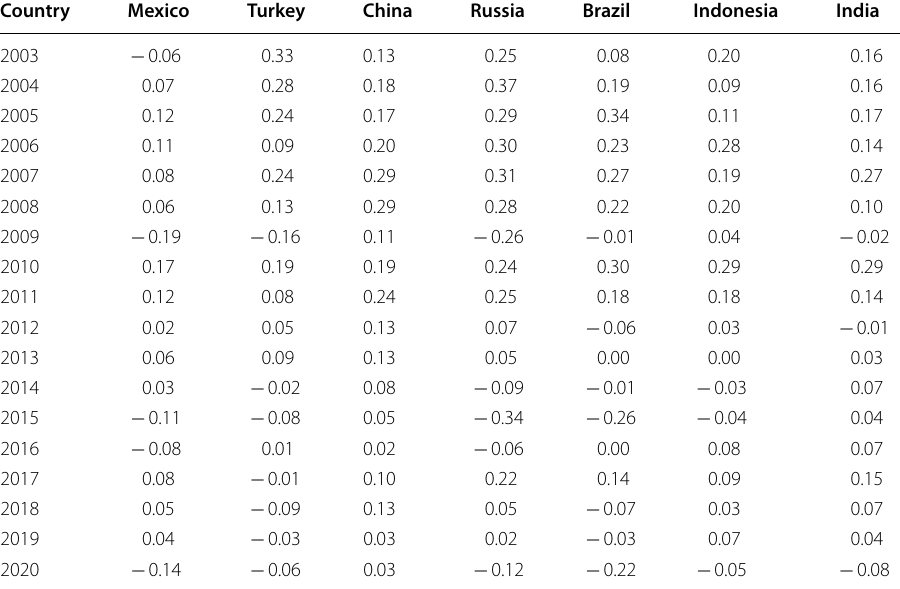
Sources Oxford Economics (2022), author’s calculations